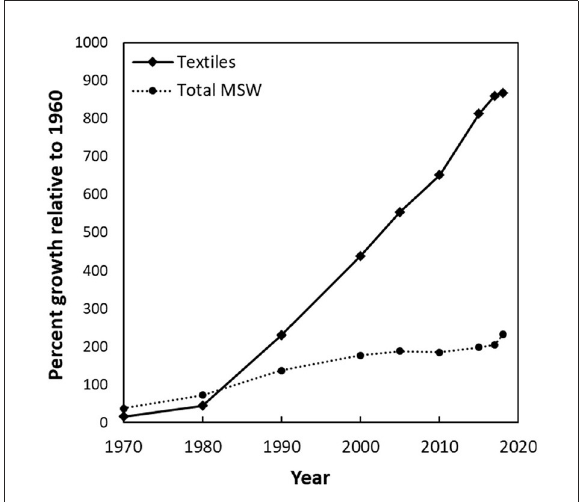
FIGURE3 Percent change since 1960 of textile waste and total municipal solid waste (MSW) generation in the U.S., based on EPA data (US EPA, 2020; Code of Federal Regulations,